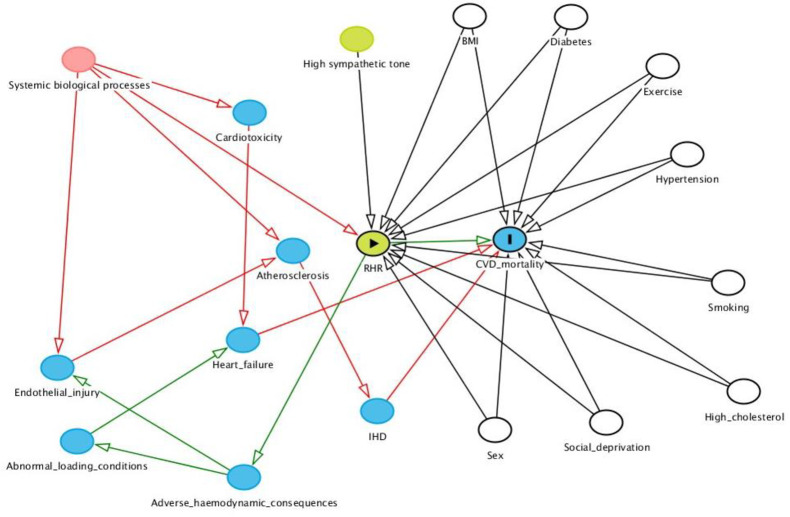
Directed acyclic graph of the potential relationships between cardiovascular disease and resting heart rate.BMI: Body mass index; CVD: Cardiovascular disease; IHD: Ischaemic heart disease; RHR: Resting heart rate. In this model: RHR = exposure and CVD mortality = outcome; Unshaded circles represent true confounders, all controlled for in fully adjusted model.